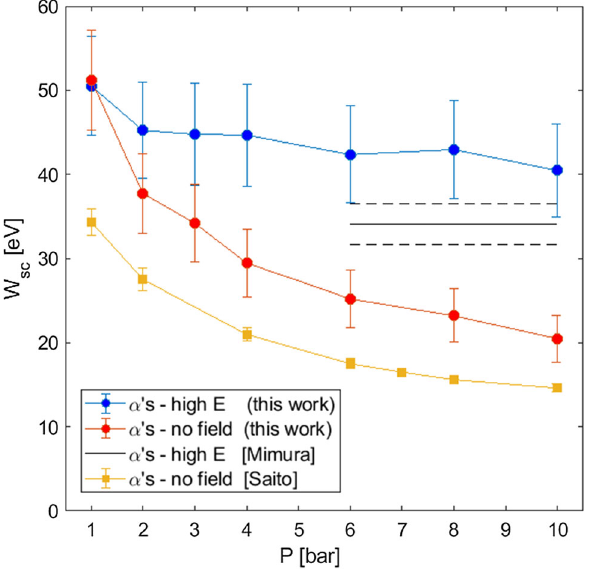
Fig. 13 Average energy to produce a scintillation photon in the 2nd continuum band ( W sc ) after PM calibration, quantum efficiency and geometrical corrections (blue and red circles), for α -particles. A com- parison with (band-unresolved) data is shown both at zero field in [24] (squares) and high field in [25] (average value shown as continuous line and error band as dashed)